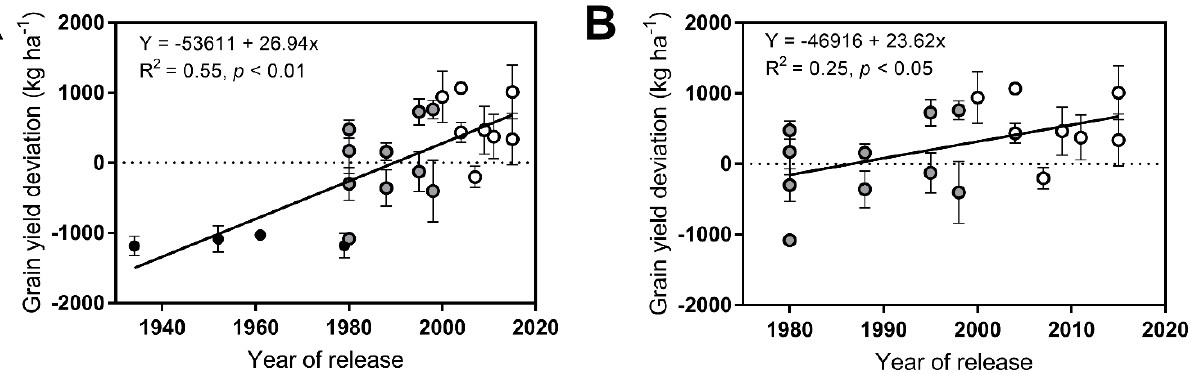
Figure 2. Linear regression analyses between grain yield deviation and ( A ) cultivars released between 1934 and 2015, and ( B ) cultivars released between 1980 and 2015. Each point represents the average of grain yield deviation for each cultivar with respect to the mean yield value in each experiment (Cabildo and Pieres in 2014 and Barrow in 2017). Black, grey and white points correspond to cultivars released in the periods 1934–1979, 1980–1999 and 2000–2015, respectively. Horizontal dotted lines represent the mean value of grain yield of each experiment, and the vertical lines for each point represent the standard error of the